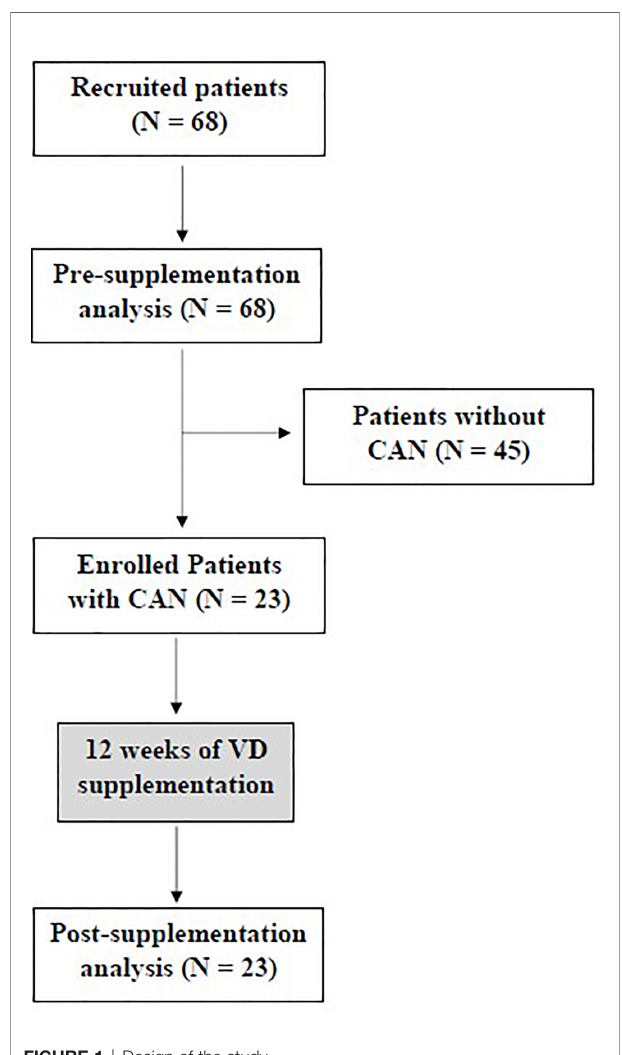
FIGURE 1 | Design of the